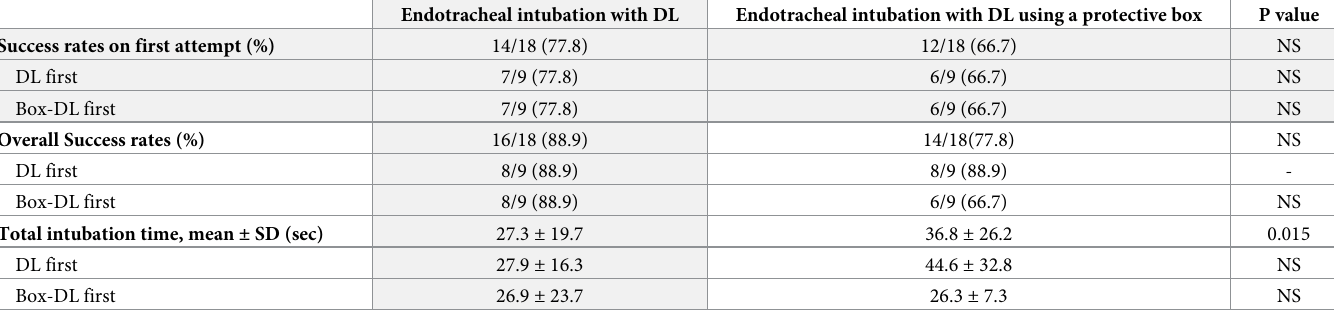
Table 1. Comparison of intubation success rates and duration between the two study groups. Endotracheal intubation with DL Endotracheal intubation with DL using a protective box P